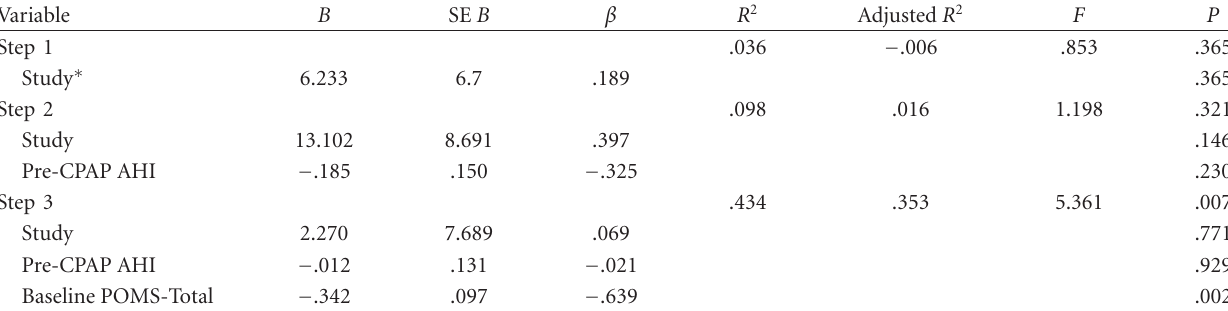
Table 3: Prediction of change in AHI (hierarchical regression analysis).